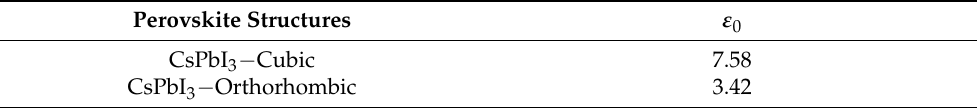
Figure 6. Real and imaginary parts of the dielectric function, electron energy loss and ε ( i ω ) of the pure inorganic perovskite: ( a ) CsPbI 3 − Cubic, ( b ) CsPbI 3 − Orthorhombic. Table 5. Static dielectric constant of CsPbI 3 for the cubic and orthorhombic phases. Perovskite